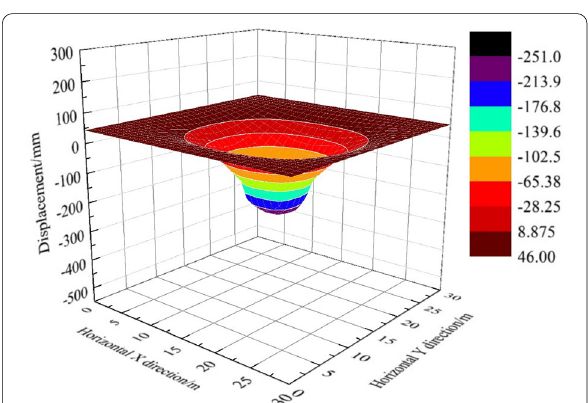
Fig. 17 Seismic subsidence of ground surface due to 0.30 g Taft ground motion (full